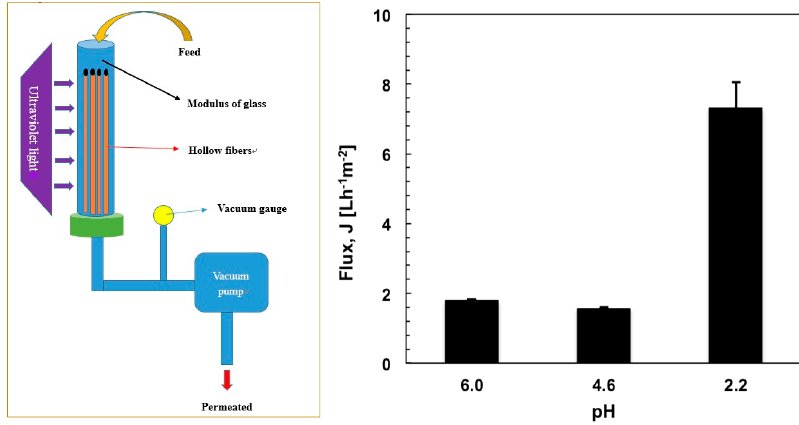
Figure 6. Modulus assembly in submerged configuration microfiltration ( a ) and average pure water flux measured through PE-LBL membranes at different pH values ( b ).